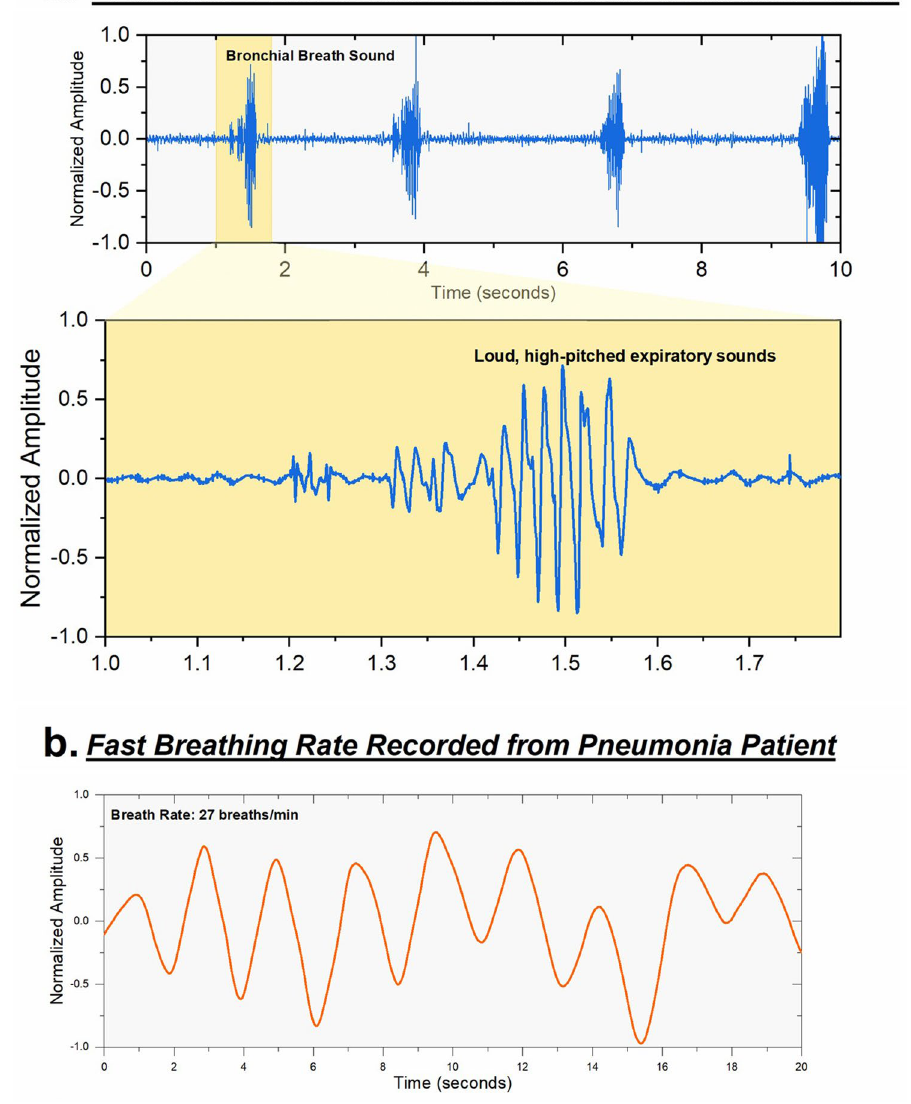
Figure 5. Pathological signals recorded from pneumonia patient. ( a ) Bronchial breath sound recorded from right inferior lobe on the posterior side from patient with pneumonia. Presence of these sounds at peripheral airways in indicative of the disease. ( b ) Pneumonia patient exhibiting a fast-paced breath rate (27 breaths/min) with a normal breathing